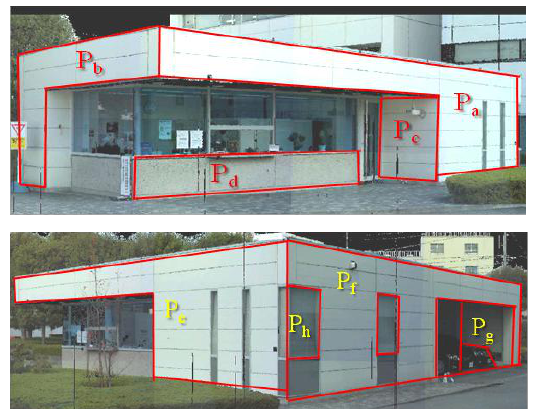
Figure 6. Selected (n=4) extracted planes in viewpoint #1 and #2.